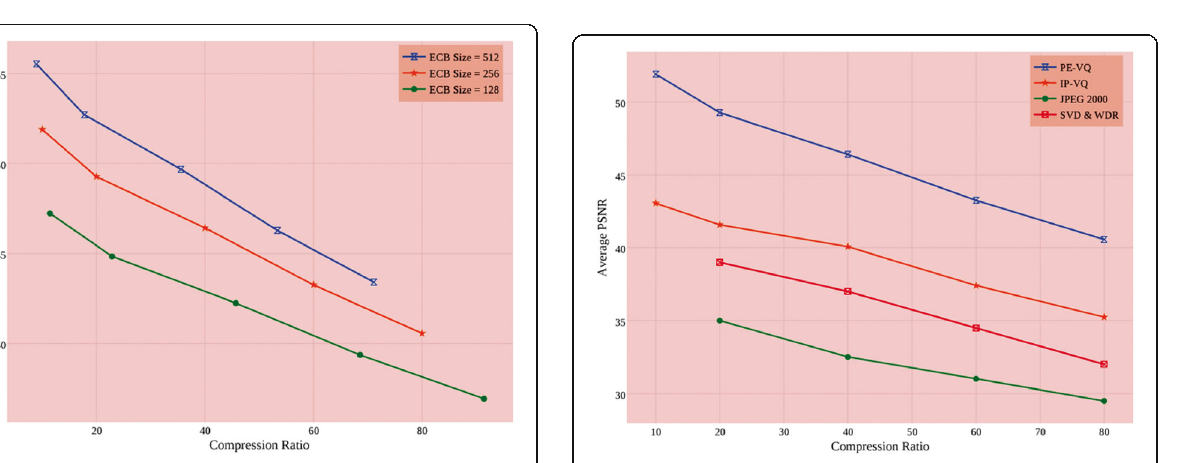
Fig. 17 Comparison of average CR and PSNR values of PE-VQ method with existing methods using